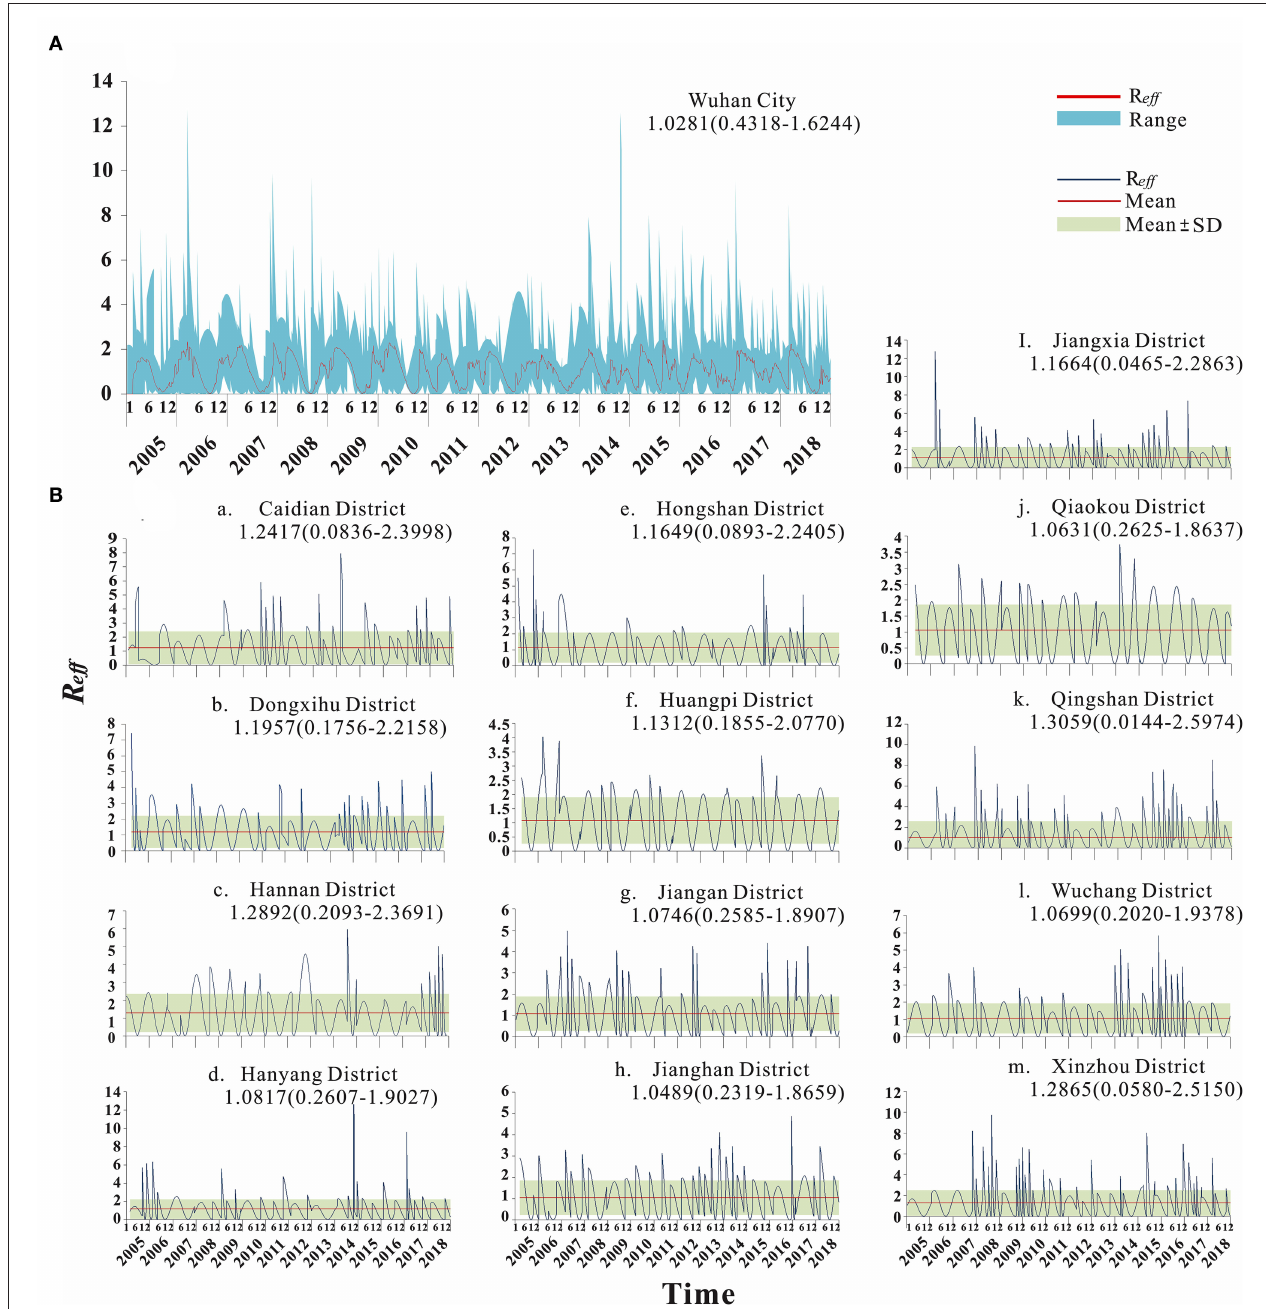
FIGURE 7 | Calculation results of transmissibility of Wuhan City and 13 districts. (A) Transmissibility of mumps in Wuhan City. (B) Transmissibility of mumps in 13 districts of Wuhan.